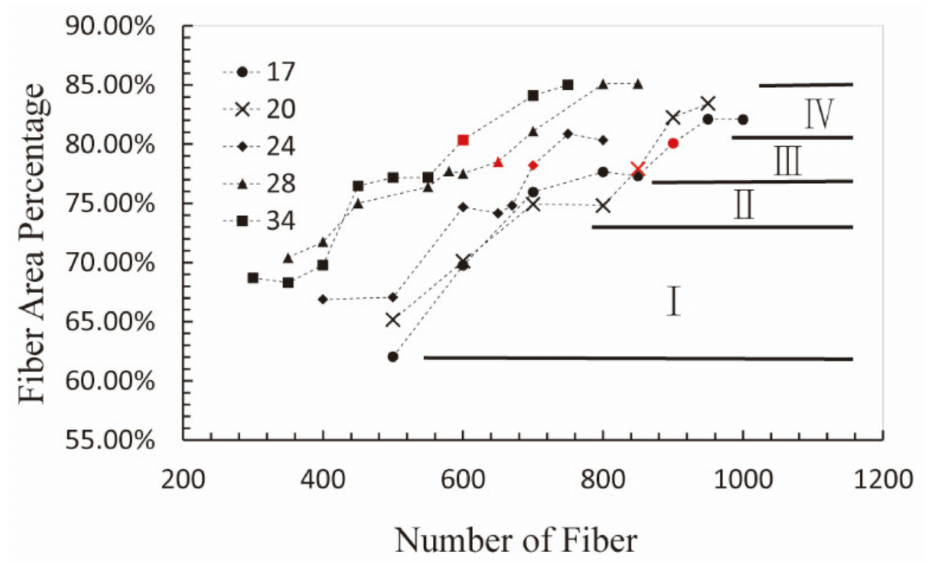
Figure 12. The variation curves of cross-section fiber area percentage with fiber number for different fiber aspect ratio, which can be divided into four stages: I, II (the first stable period), III, IV (the second stable period). The red symbol is the optimum fiber number determined hereinbefore.